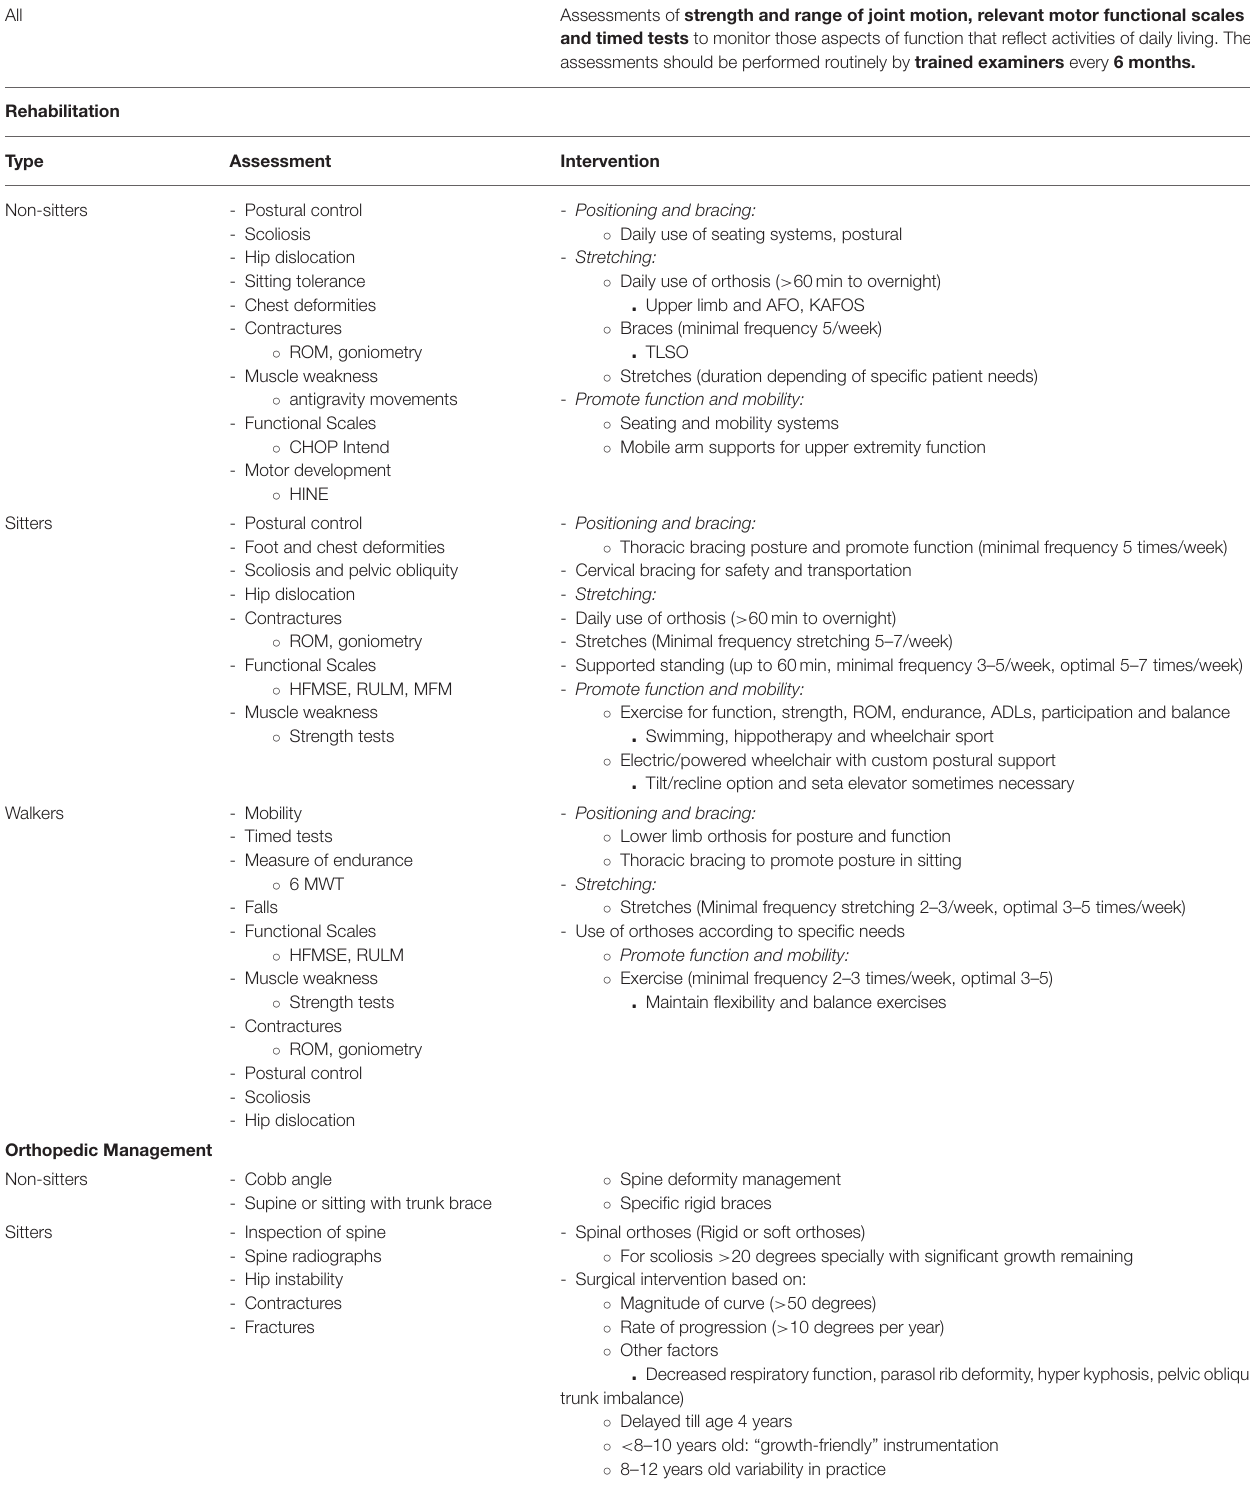
TABLE 1 | Summary of recommendations on SoC. Neuromuscular and musculoskeletal evaluation